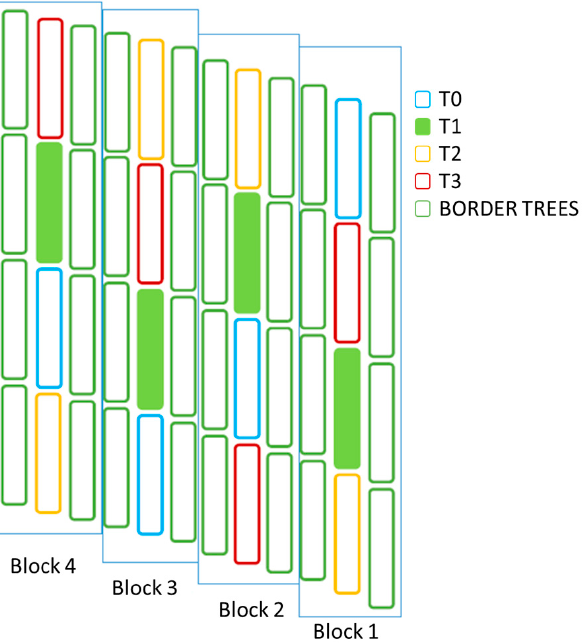
Figure 1. Distribution of deficit irrigation treatments (2018 and 2019 seasons) at a super-high density ‘Arbequina’ olive trees orchard.